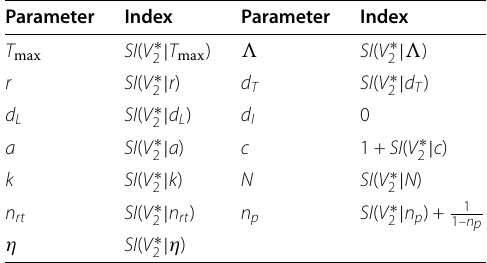
Table 9 Sensitivity indices for chronic non-infected free virus population W ∗